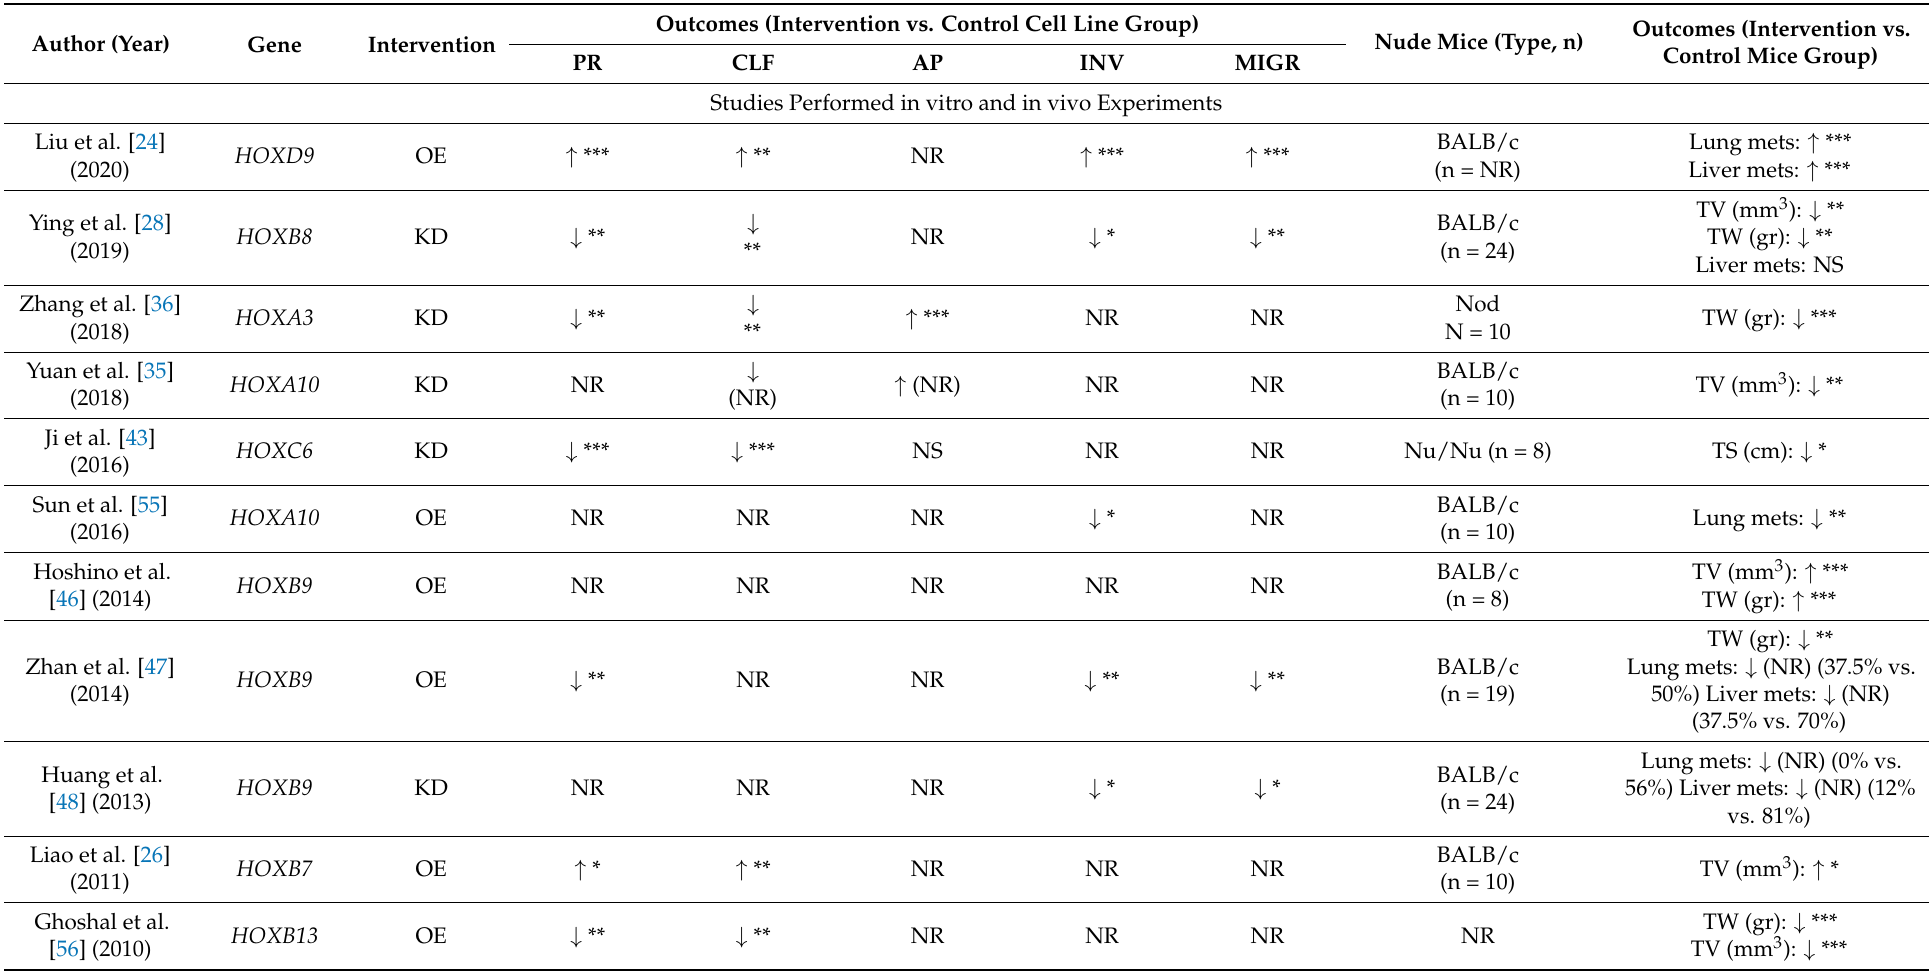
Table 3. Summary of findings of the included studies that performed both in vitro and in vivo experiments on the functional role of HOX genes dysregulation in CRC